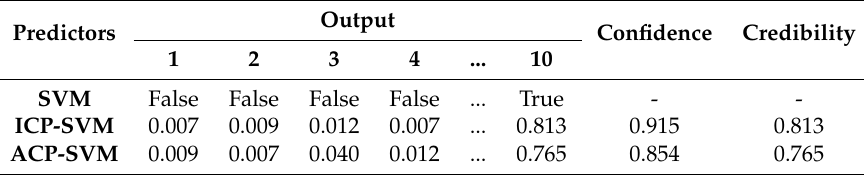
Table 4. Output of different predictors for No. 45